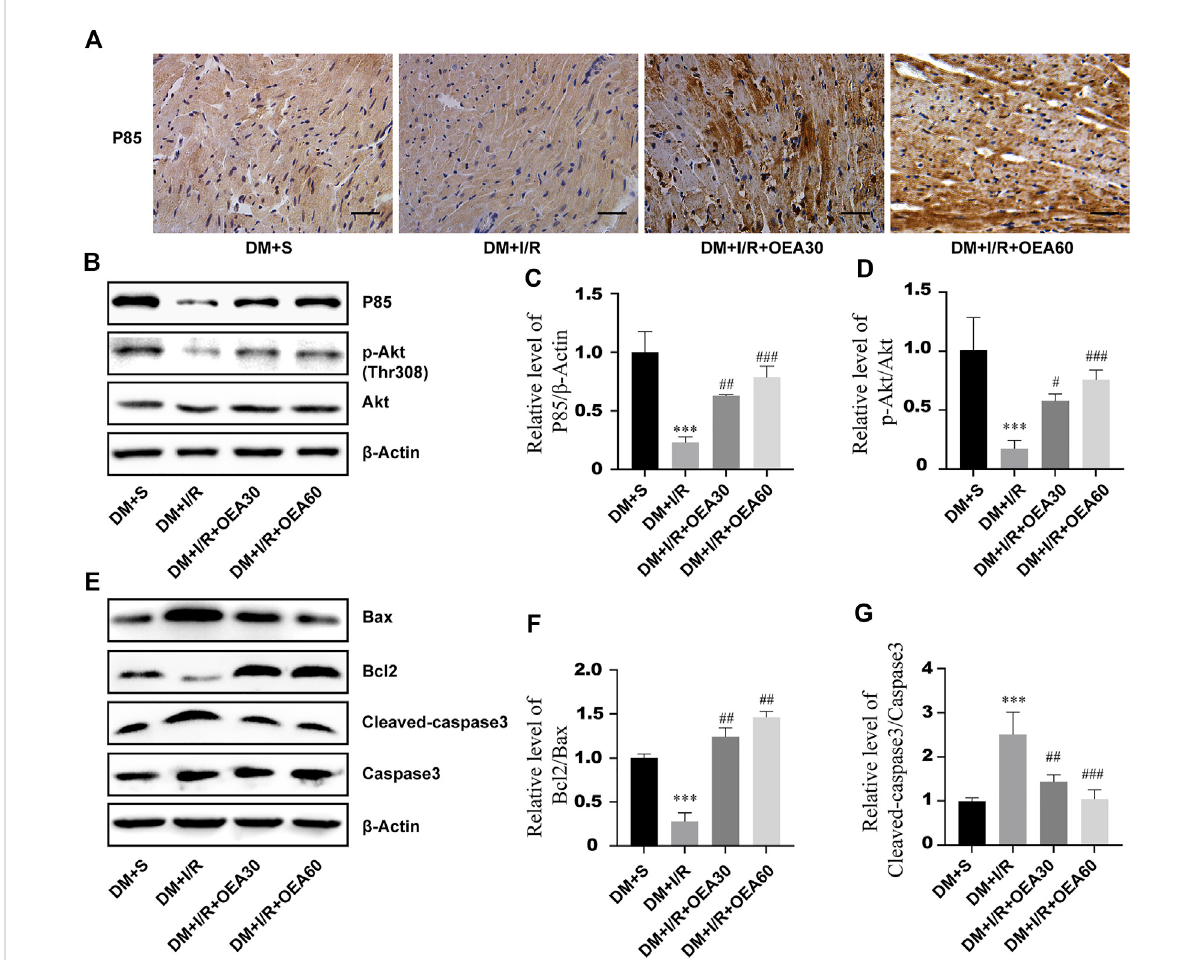
OEA activated the PI3K/Akt signaling pathway and downregulated the expression levels of apoptosis-related proteins. (A) The expression level of P85 in rat myocardium was detected by immunohistochemistry, scale = 50 μ m. (B – G) WB was used to detect the expressionlevels of P85, p-Akt, Bax, Bcl-2 and cleaved caspase-3 proteins in myocardial tissues of rats in each group. Data were expressed as mean ± SEM, *** p < 0.001 vs. DM + S group; # p < 0.05, ## p < 0.01, ### p < 0.001 vs. DM + I/R